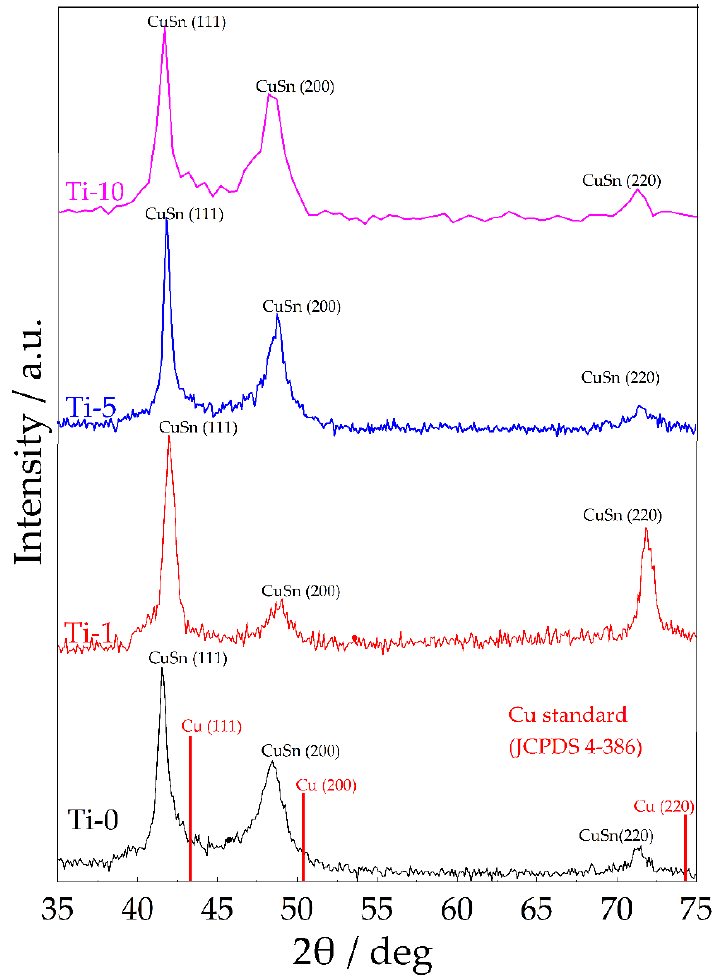
Figure 7. XRD patterns of Cu – Sn and Cu – Sn – TiO 2 coatings (thickness 10 µm).